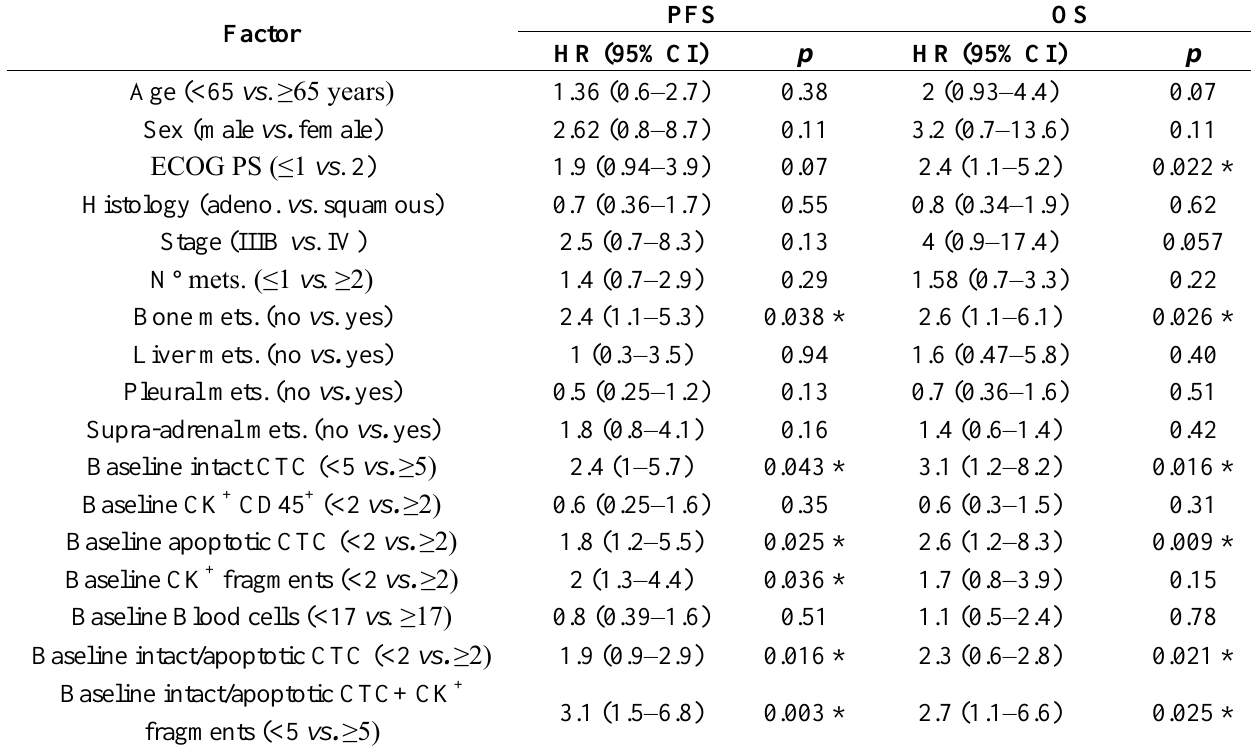
Table A1. Univariate Cox regression